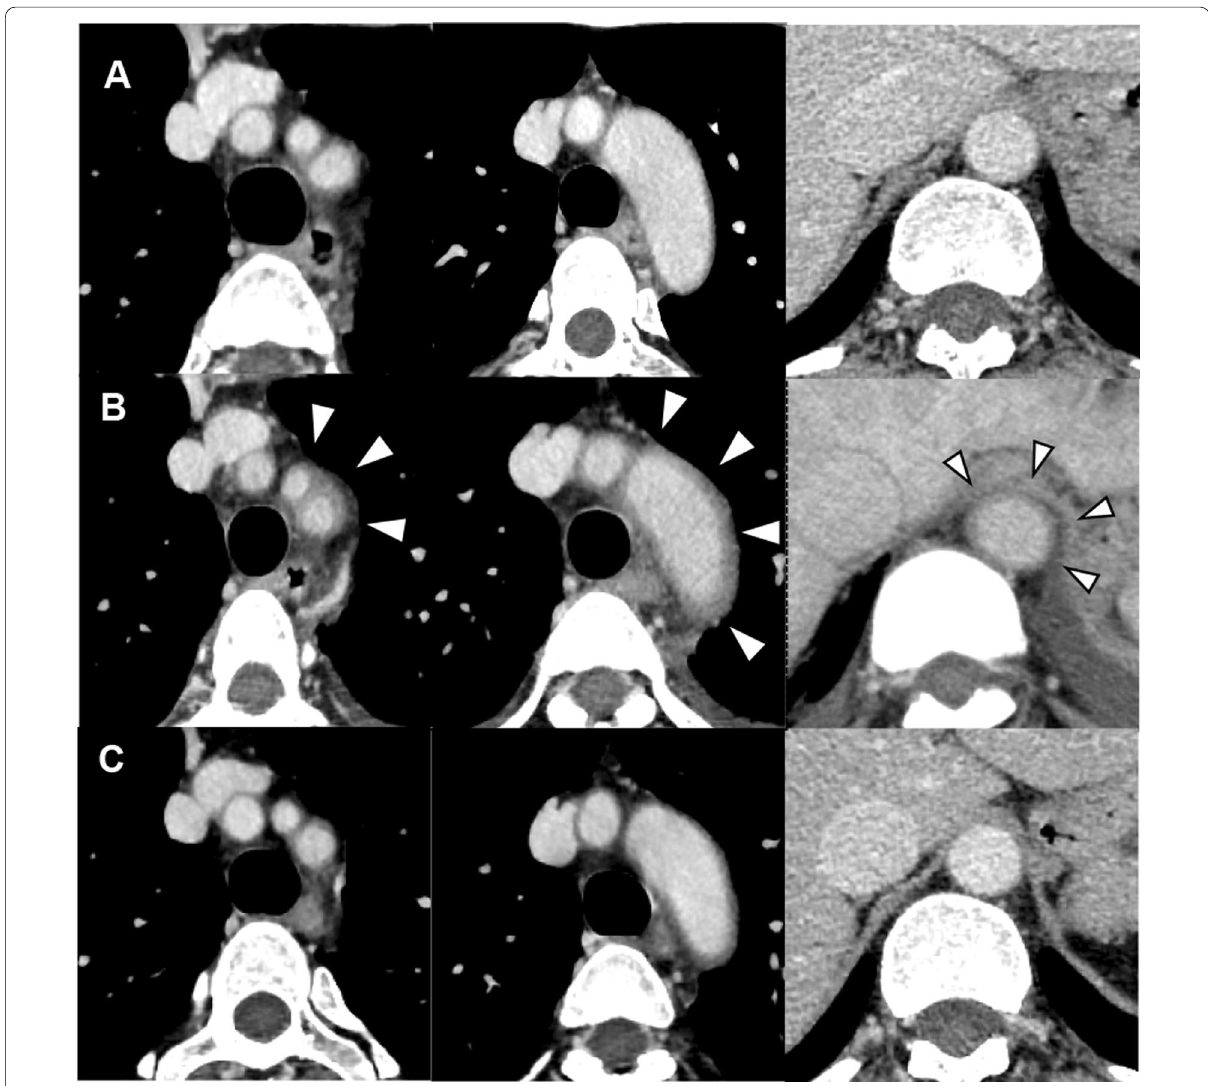
Fig. 2 Contrast-enhanced CT images before and after treatment. A CT images before chemotherapy. B Contrast-enhanced CT images before treatment (day 8), showing thickened vessel walls in the left subclavian artery, the origin of the common carotid artery, and the thoracoabdominal aorta (white arrowheads). C Contrast CT images after treatment (day 22), showing improvement in the perivascular wall thickening. CT